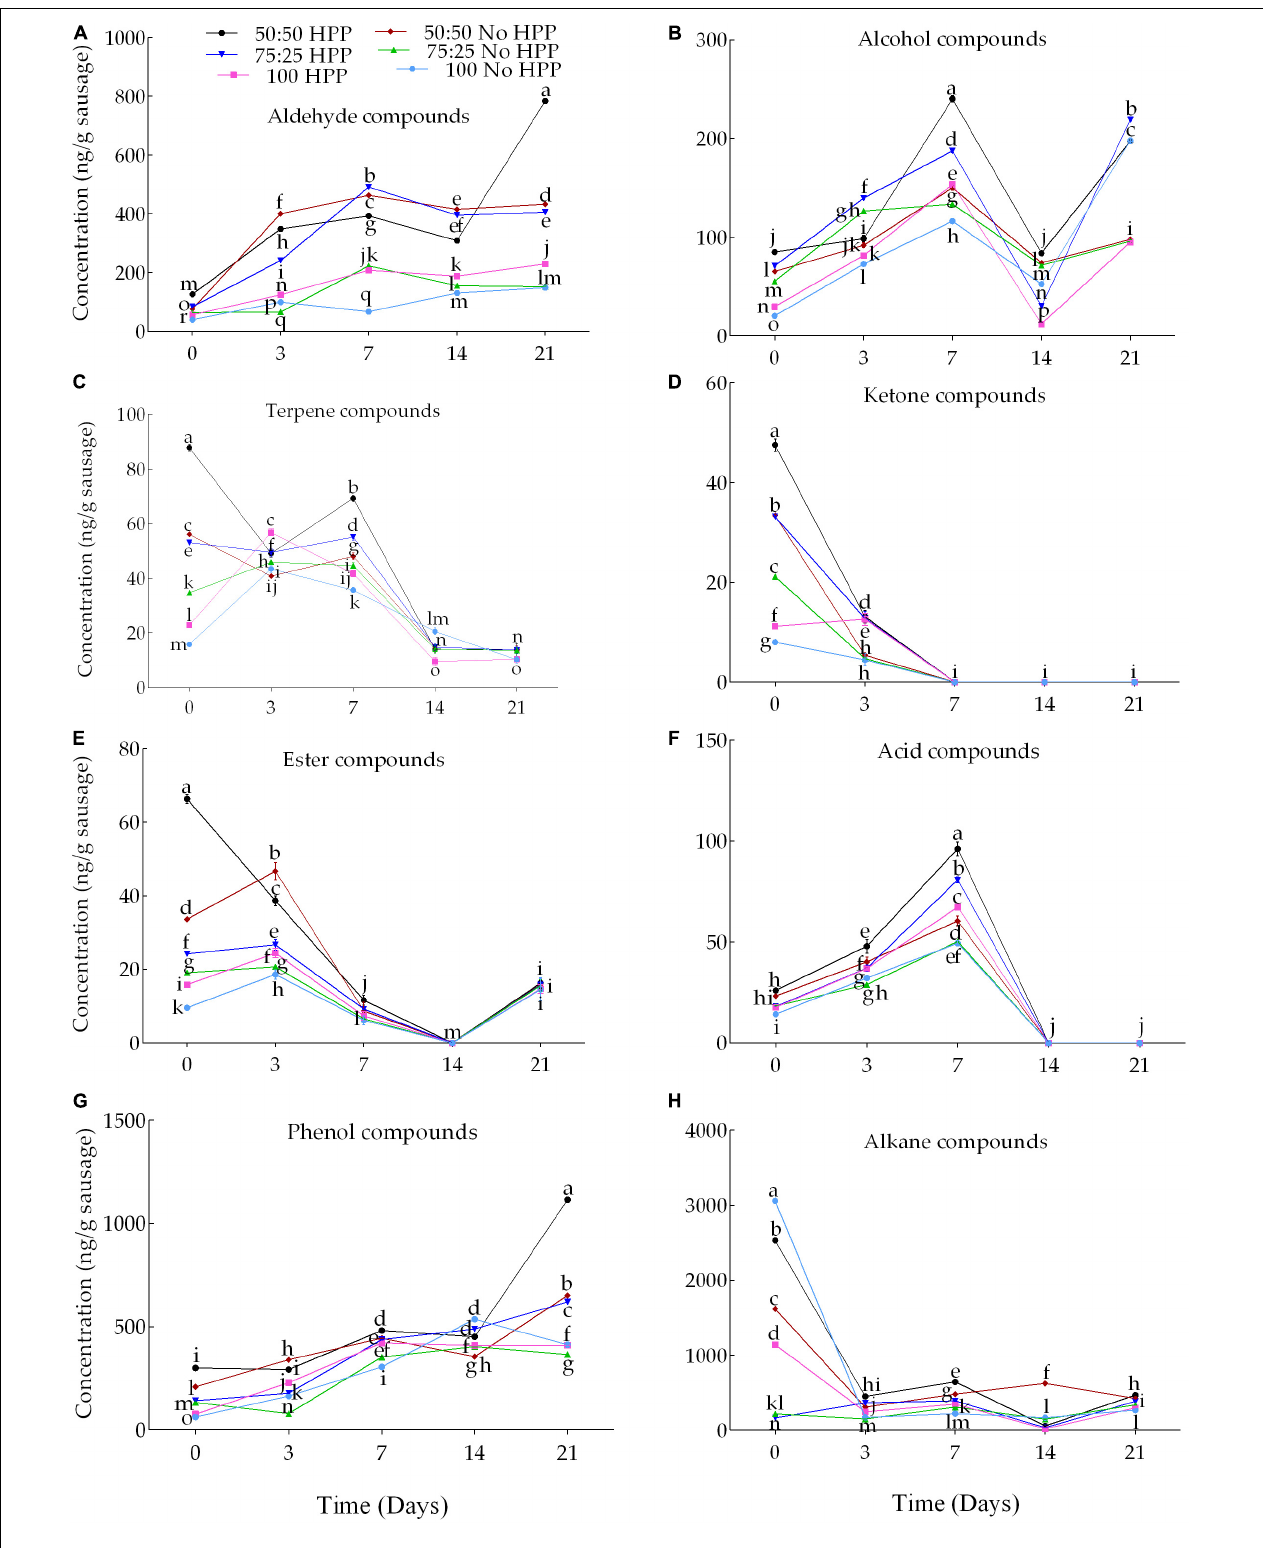
FIGURE 3 | Effects of partial substitution of NaCl with KCl at 0 25 and 50% coupled with HPP on volatile compounds [ (A) aldehyde, (B) alcohol, (C) terpene, (D) ketone, (E) ester, (F) acid, (G) phenol and (H) alkane] under five (0, 3, 7, 14, and 21) different cold storage days (4 ◦ C). HPP treated at 100 MPa for 5 min at 25 ◦ C. Bars indicate standard error of the means. At each of the storage times, different letters indicate significant ( P < 0.05) differences between treatments.